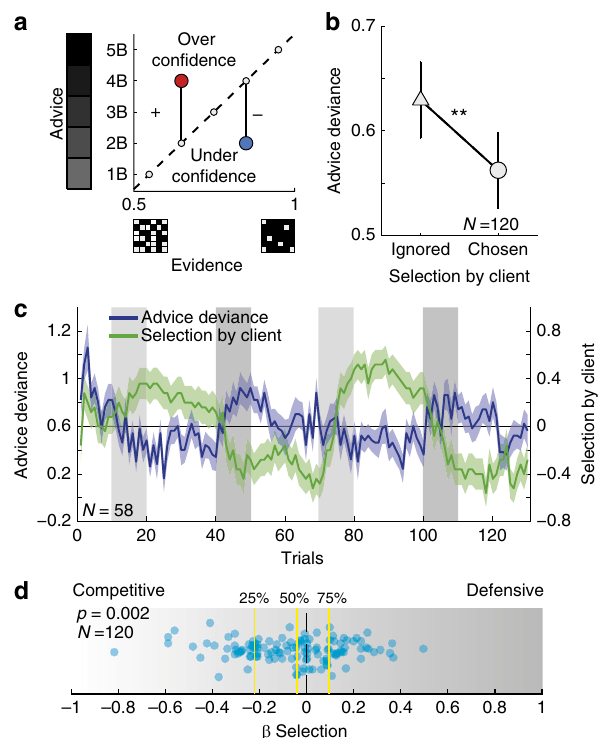
Fig. 2 Selection by client effect on advice. a Deviance of advice from probabilistic evidence. Con fi dence is plotted against evidence grid, i.e., probability that coin is in the black urn. The dashed line represents zero- deviance policy in which con fi dence matches the ratio of black to white squares in the evidence grid. Overcon fi dent advice (red circle) would lie above the dashed line and was de fi ned as positive deviance; conversely, undercon fi dent advice (blue circle) corresponded to negative deviance. b Averaged advice deviance under high vs. low selection (paired t-test, t(119) = 3.10, P = 0.002). c The dynamic interplay of selection and advice deviance in the online experiment. Blue line = trial-by-trial average advice deviance. Green line = average selection. Light green and blue = SEM. Light and dark grey blocks mark periods of low evidence reliability for the rival and for the participant, respectively (see Fig. S1). d Our best- fi tting model contained a parameter governing how selection by client affect advice deviance, ‘ β -Selection ’ . Positive values of β -Selection are associated with the defensive strategy, i.e., increased advice deviance when being selected. Negative values are associated with the competitive strategy, i.e., decreased advice deviance when being chosen by the client. Despite high level of individual differences, this parameter was signi fi cantly lower than 0 across participants (Mean ± SEM = − 0.08 ± 0.02, t(119) = 3.12, P < 0.002), in line with our previous